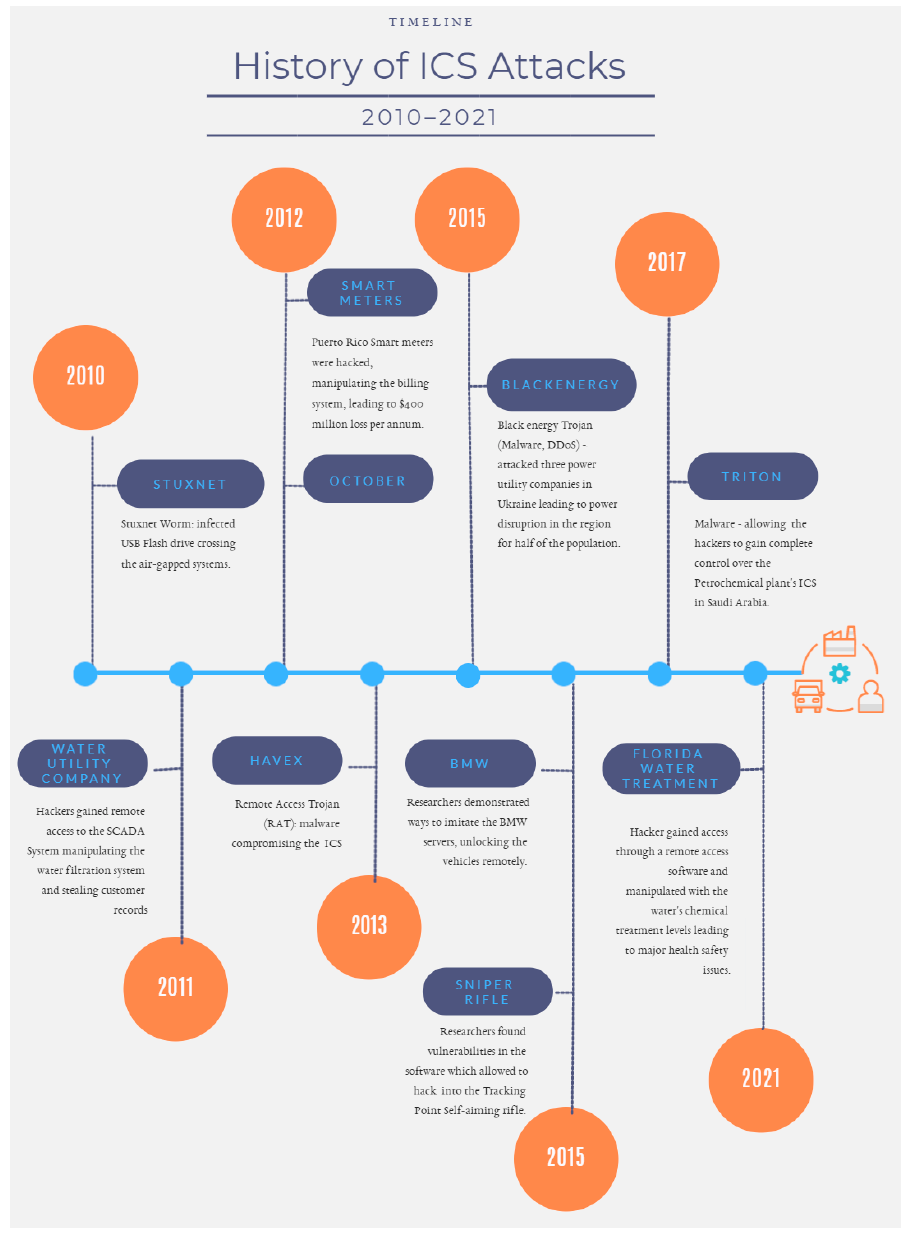
Figure 3. Timeline and history of ICS cybersecurity attacks.